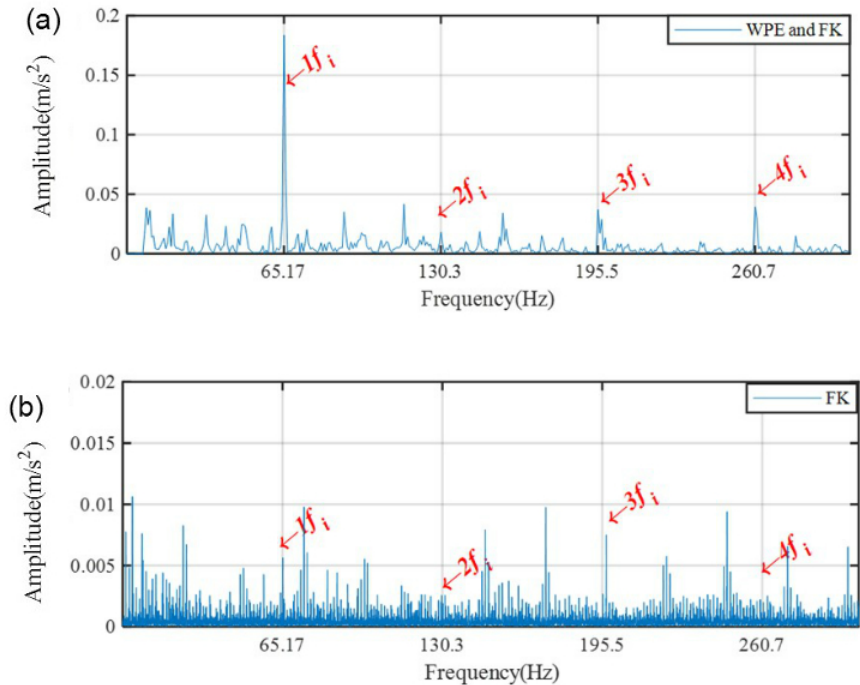
Figure 14. Energy distribution proportional histogram of the vibration signal.